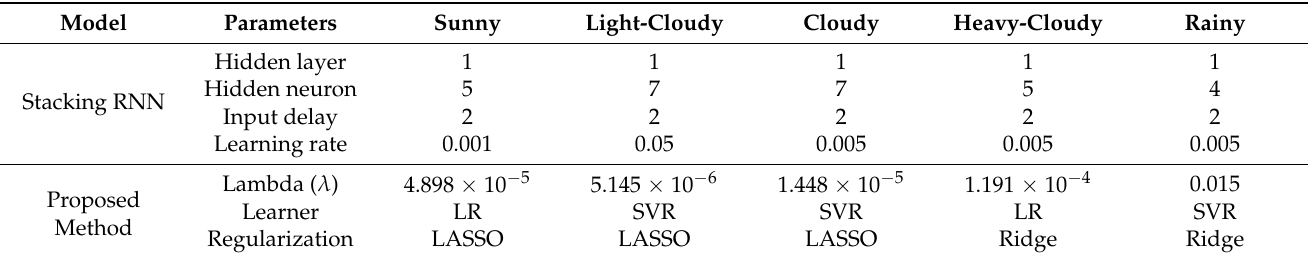
Table 5. Hyperparameters for the ensemble model.